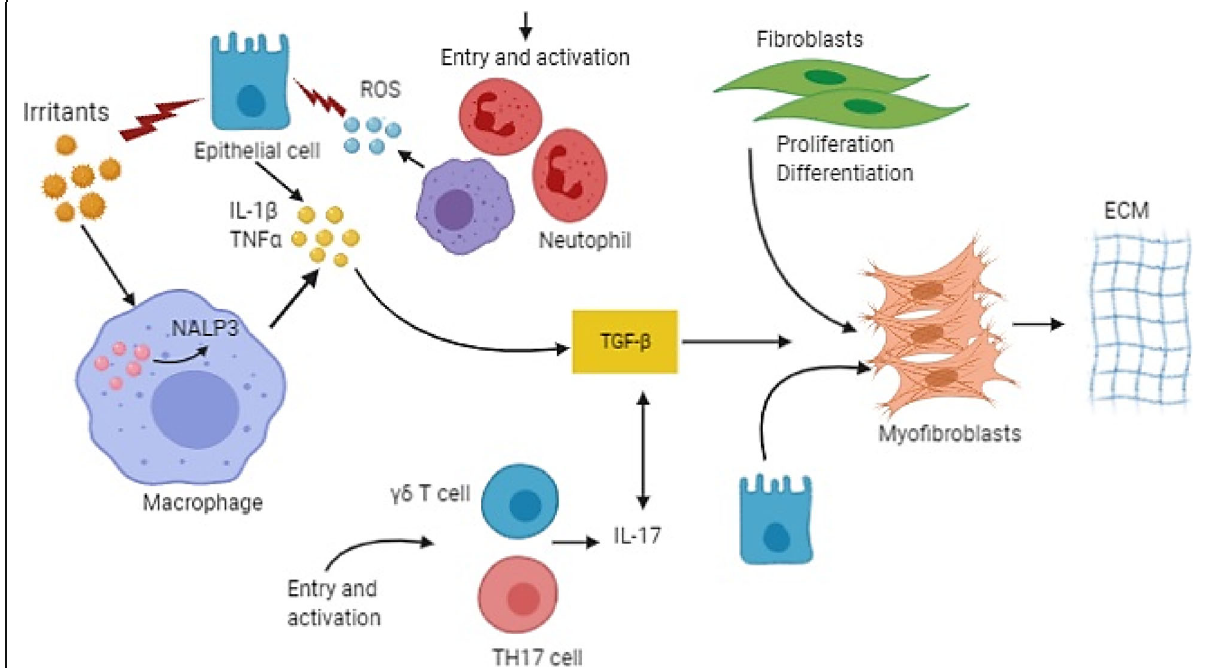
Fig. 2 Effect of proinflammatory and pro-fibrotic mediators